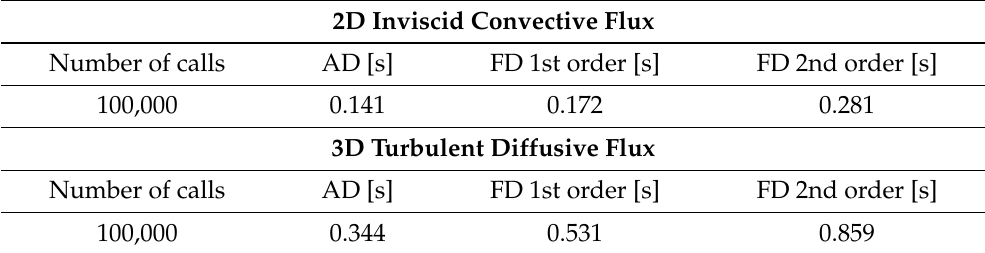
Table 2. Time required for the evaluation of the Jacobian matrix of some routines through AD and FDs with ideal gas